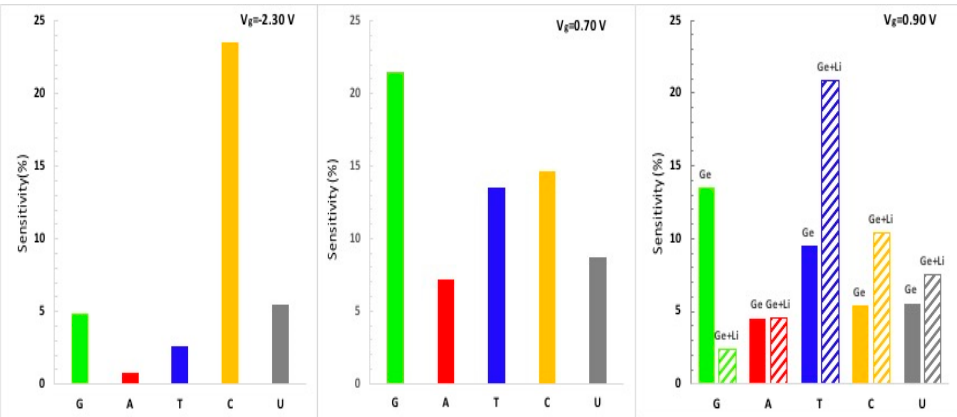
Figure 9. For different gate voltages (left panel V g = − 2.30 V and middle panel V g = 0.70 V), the calculated sensitivity histogram of the theoretical germanene sequencing biosensor with five different nucleobases is plotted. For the gate voltage V g = 0.90 V (right panel), we compared the sensitivity histogram of each nucleobase on bare germanene (Ge stands for bare germanene) and Li-supported germanene (Ge + Li stands for Li-supported germanene).